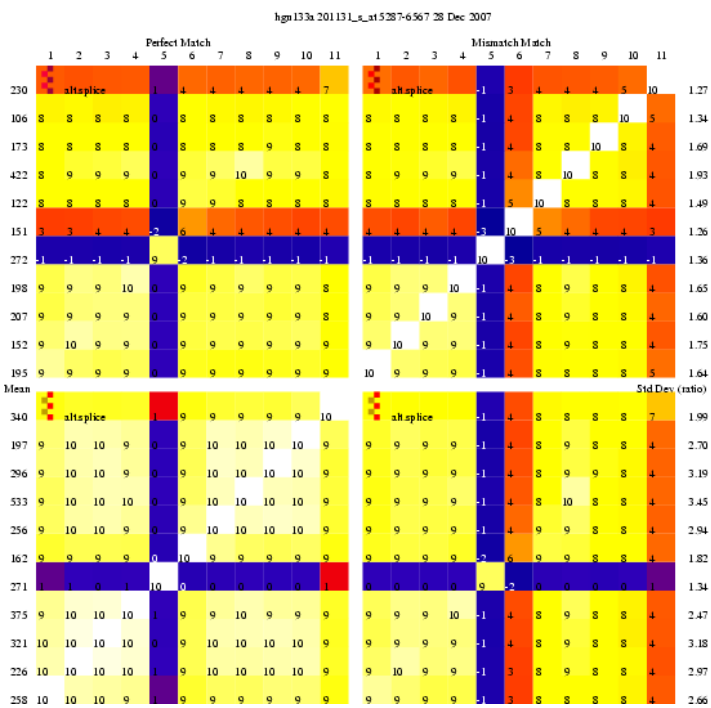
Figure 10: The correlations in intensities (log2) between probes in probeset 201131 s at on HG- U133A. Probe 5 for both the PM and MM appears poorly correlated with the other probes. Out- liers should be removed before the calculation of